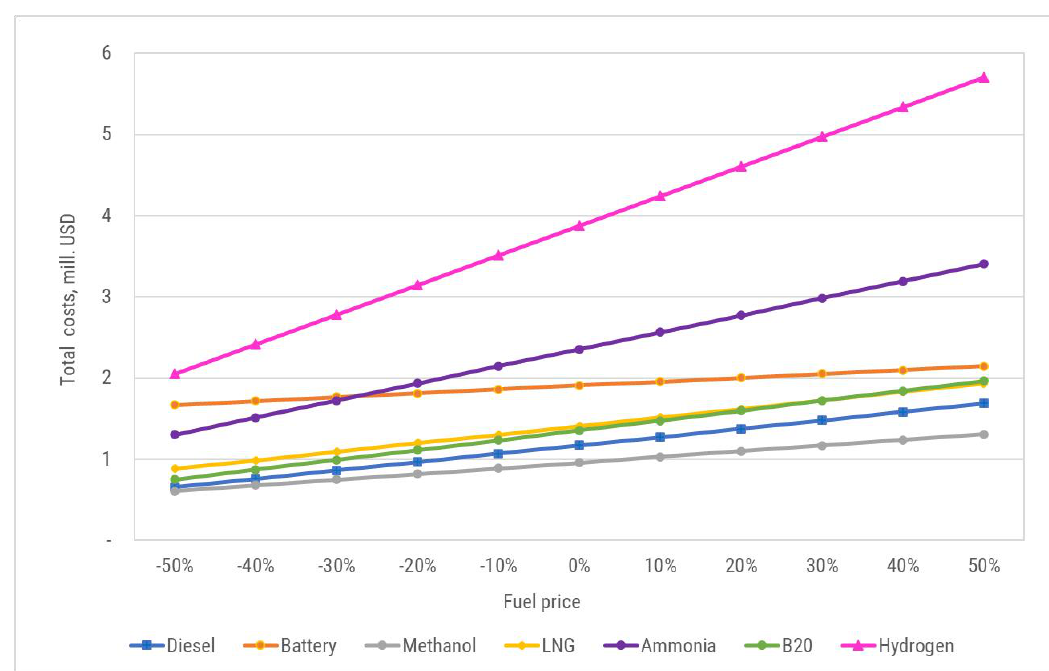
Figure 15. Total costs with respect to fuel price fluctuations.